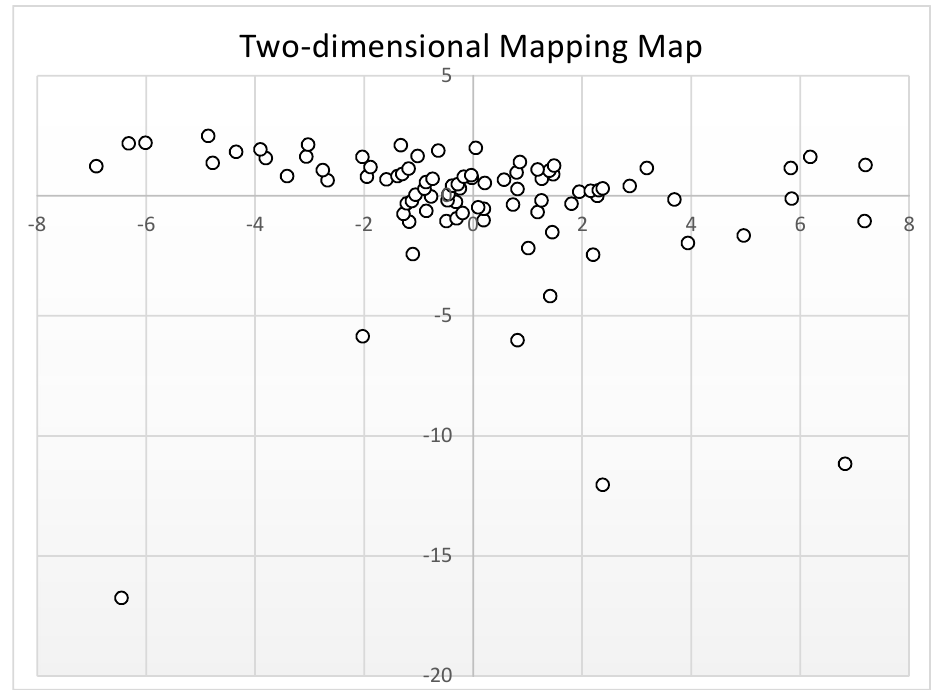
Figure 6. Two-dimensional map of small and medium watershed data sets.